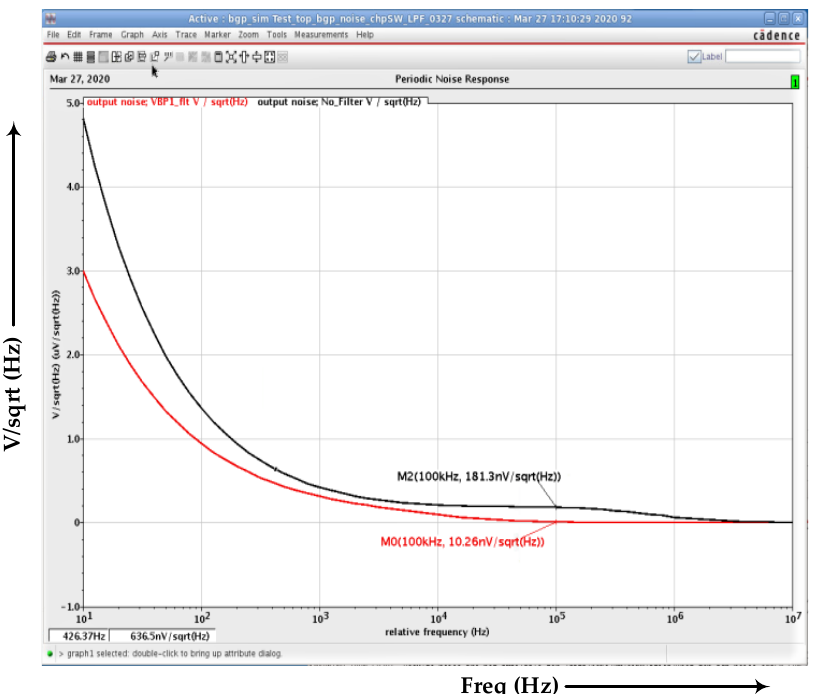
Figure 17. Noise reduction simulation graph for the chopped bandgap with a filter and without a filter.